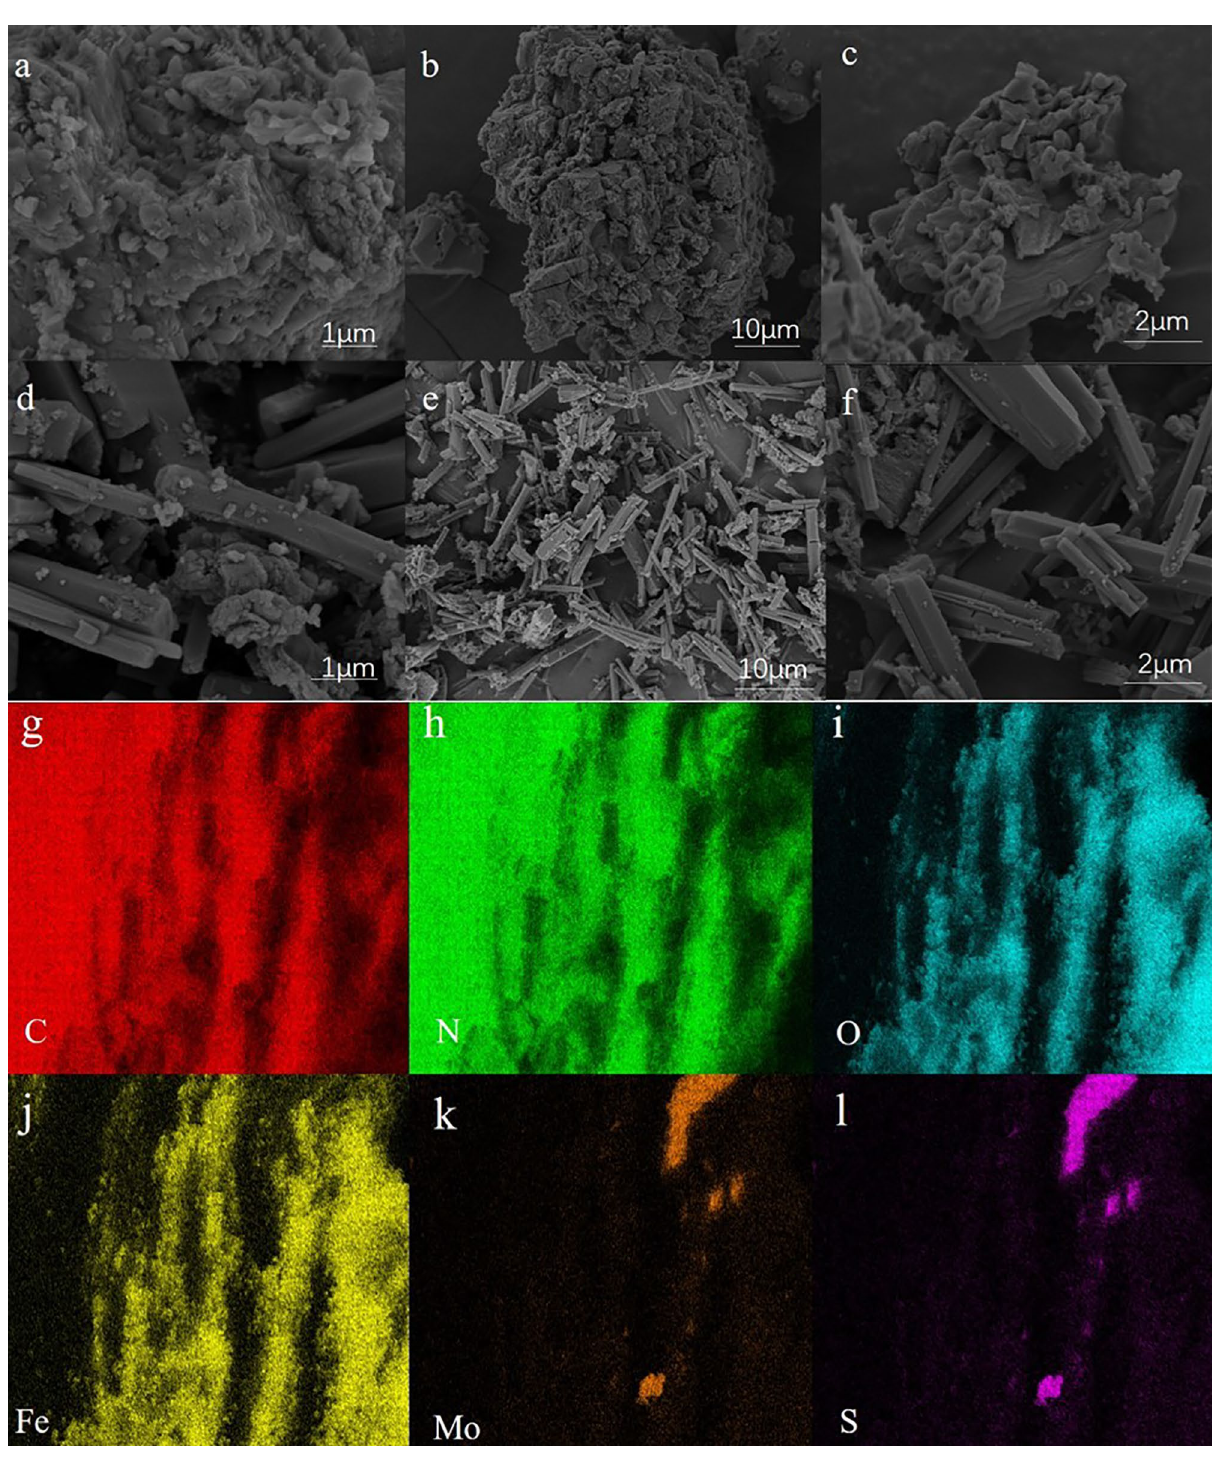
Figure 3. SEM images of CN: ( a ) 40,000×, ( b ) 5000×, ( c ) 20,000×, MoS 2 /Fe 2 O 3 /CN ( d ). 40,000×, ( e ) 5000×, ( f ) 20,000×, and the corresponding elements mapping of MoS 2 /Fe 2 O 3